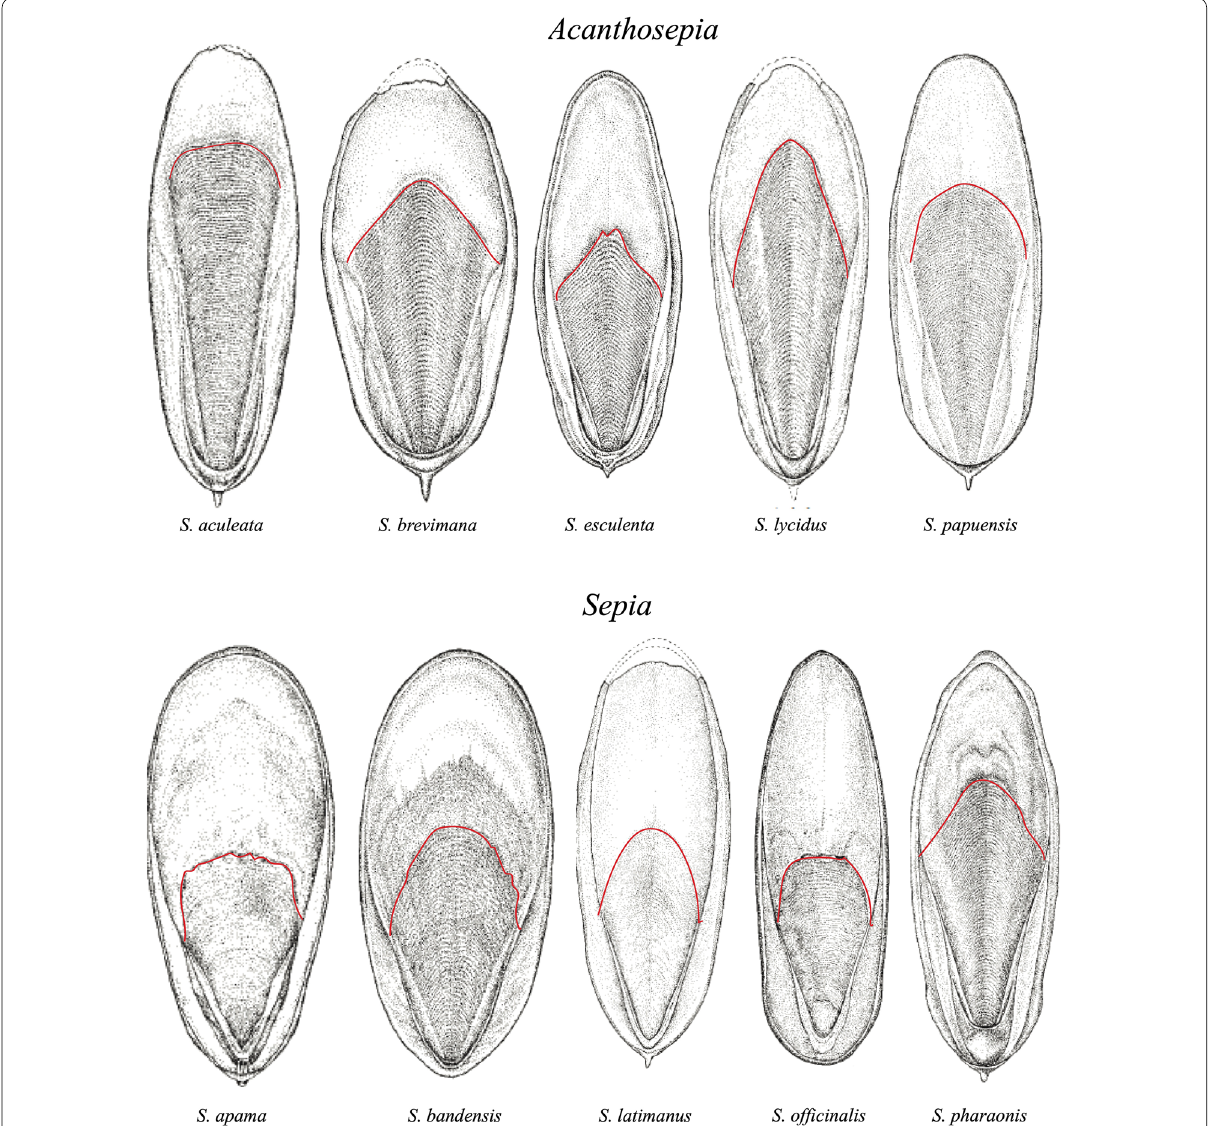
Fig. 6 Cuttlebones of Acanthosepia and Sepia subgenera. These species have been shown to mainly inhabit depths of 100 m or